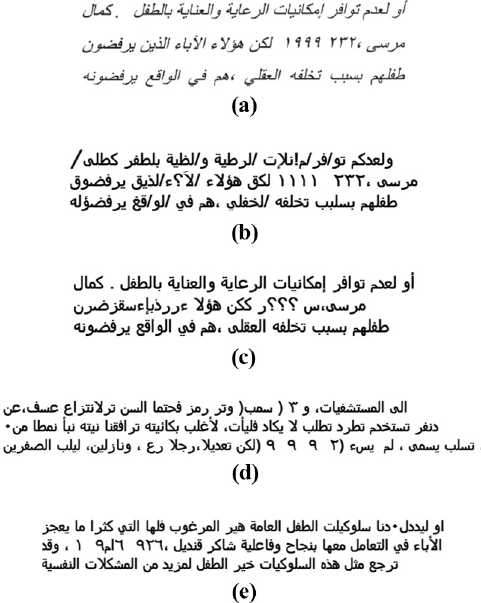
Figure 2. (a) A text image from the KAFD dataset; (b) output of the Sakhr OCR system; (c) output of the